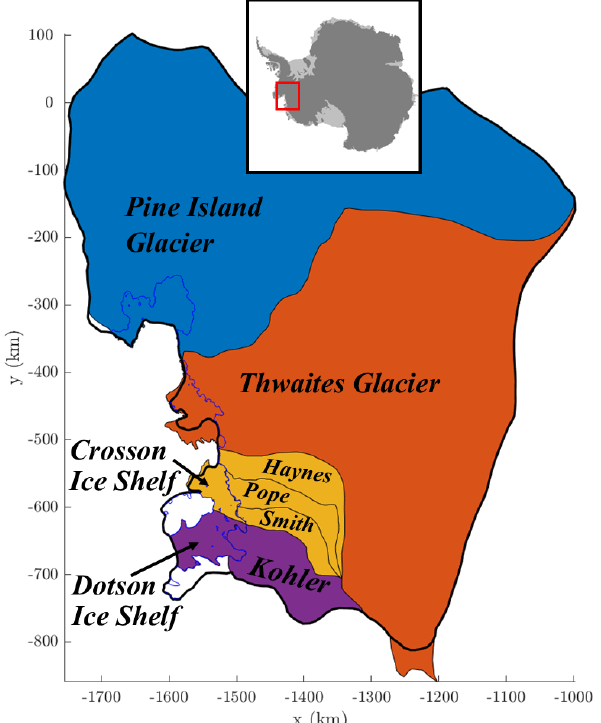
Figure 1. The catchment basins of the Amundsen Sea Embayment (ASE) using MEaSUREs Antarctic boundaries (Rignot et al., 2013) and, inset, the location of the ASE within Antarctica. The different colours indicate the four regions we focus on. The thicker black out- line is the boundary of our model domain, and the initial grounding line is indicated in